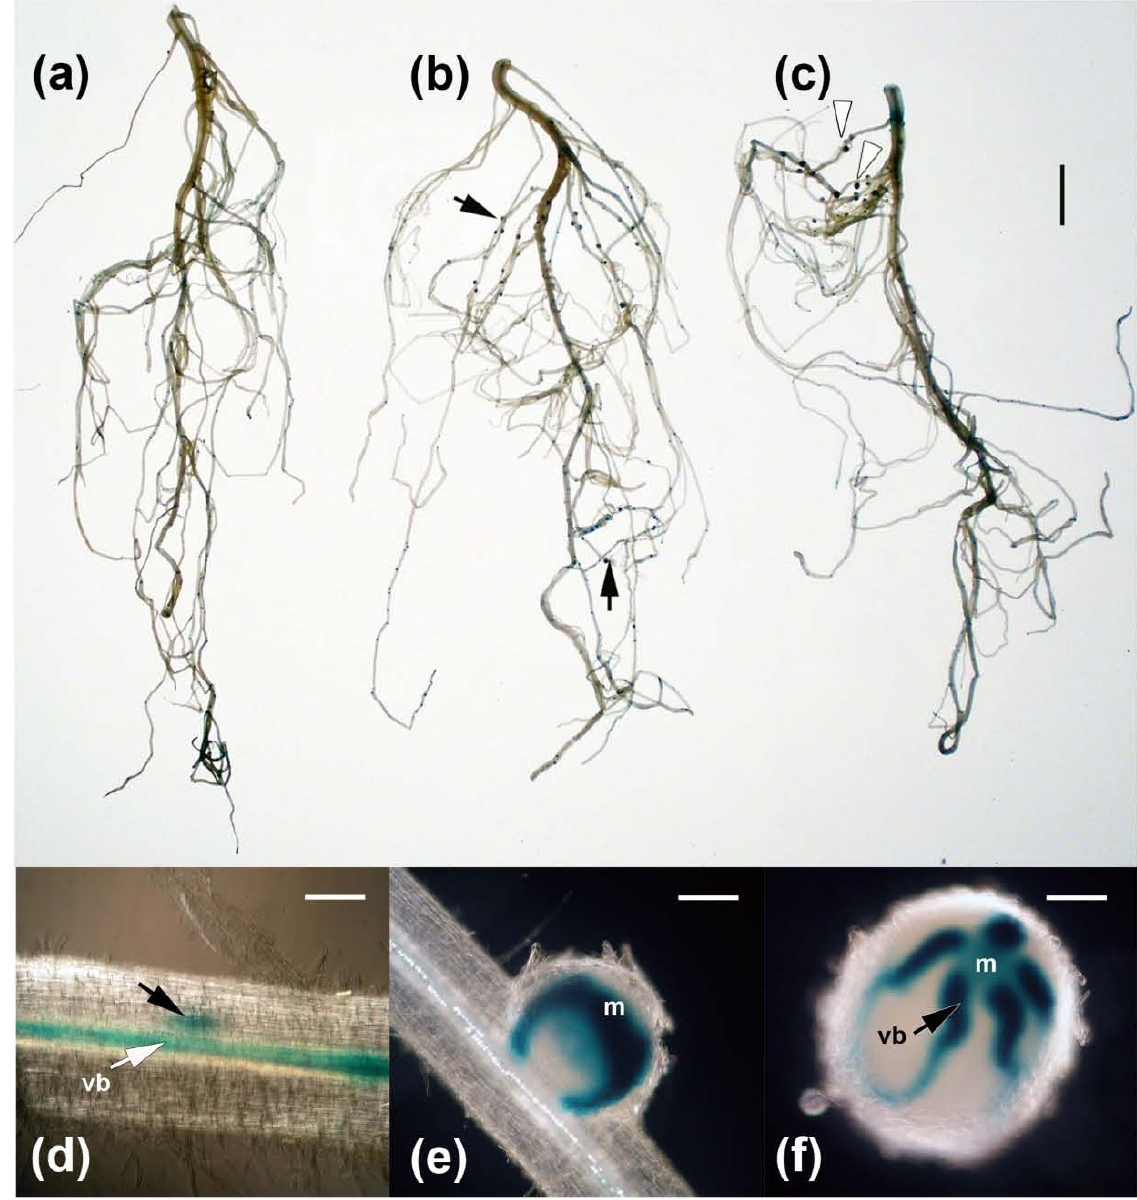
Figure 4. GUS staining of pea roots and nodules 14 dpi; ( a ) Uninoculated control. GUS staining is mostly localized to the lateral root primordia and the youngest root tips; ( b ) Root inoculated with R. leguminosarum bv. viciae . The blue color is detected in the nodules (arrows), lateral root primordia, and in young root tips; ( c ) Root coinoculated with B. simplex and Rlv. The nodules (white arrowheads) are larger and clustered closer to the crown of the root. Bar, 1 cm; (d) Nodule primordium (black arrow) 10 dpi with R. leguminosarum bv. viciae . The white arrow points to a vascular bundle (vb); (e) Emergent nodule (ca. 14 dpi) with GUS staining in the nodule meristem (m) and young vascular bundles; (f) Staining is apparent in the nodule meristem (m) and most recently developed vascular bundles (vb) (arrow); 32 dpi; Bars, 200